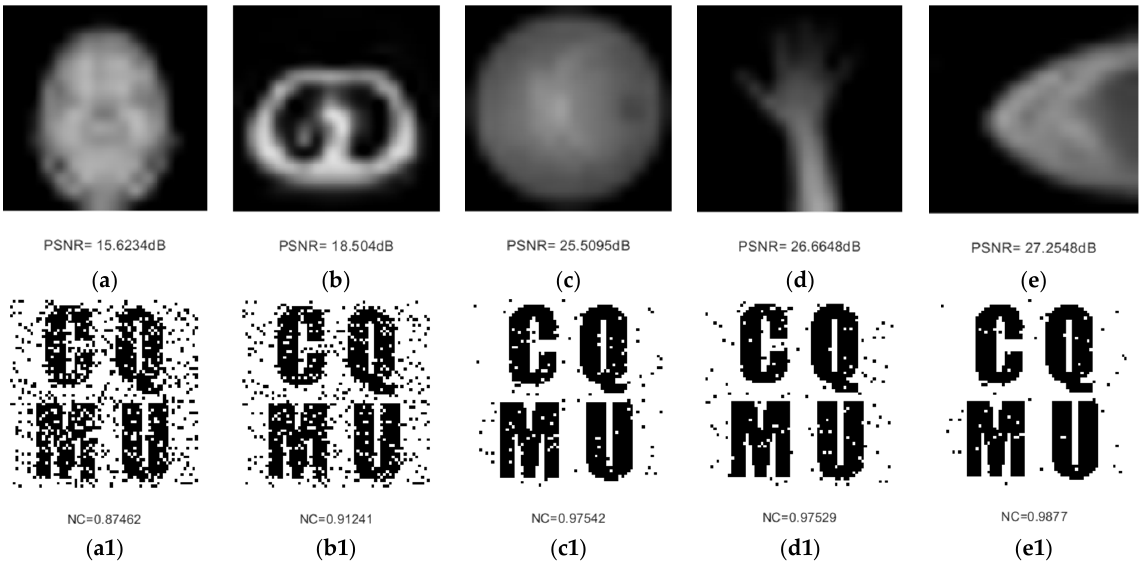
Figure 13. Attacked medical images and restored watermarking images under scaling factors 0.125 then factors 8: ( a , a1 ) brain and extracted watermarking image; ( b , b1 ) chest and extracted watermarking image; ( c , c1 ) fundus blood vessels and extracted watermarking image; ( d , d1 ) hand and extracted watermarking image; and ( e , e1 ) breast and extracted watermarking image. Table 5. The result under scaling attacks.